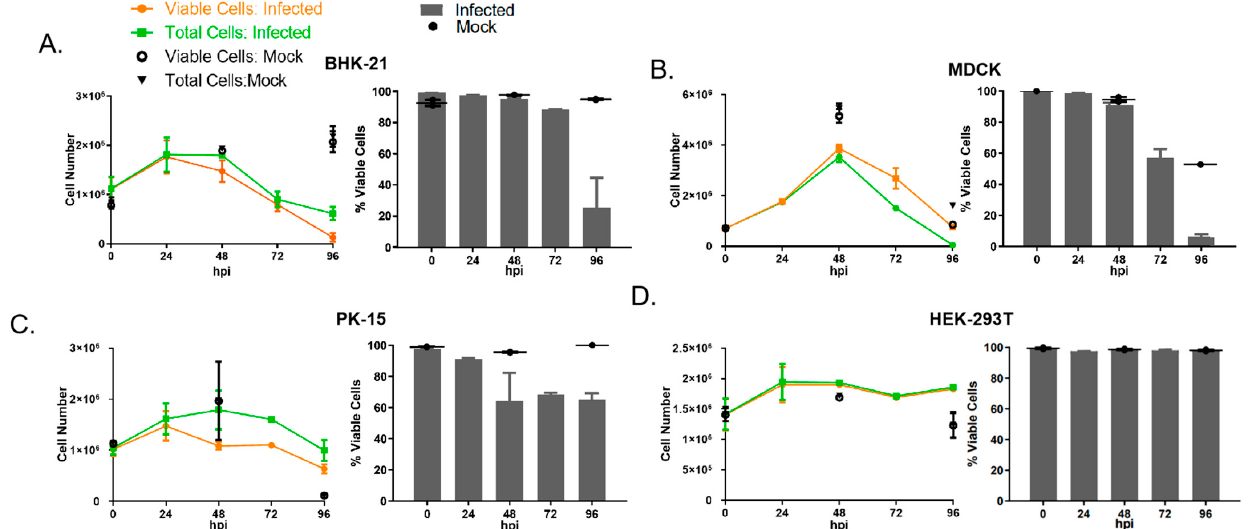
Figure 2. Cell numbers and viability following infection with WUXV SXWX1813 ‐ 2. ( A ) BHK ‐ 21, ( B ) MDCK, ( C ) PK ‐ 15 and ( D ) HEK ‐ 293T cells were infected with WUXV SXWX1813 ‐ 2 at a multiplicity (MOI) of 0.05 and collected at 0, 24, 48, 72, and 96 hpi; mock ‐ infected samples were collected at 0, 48, and 96 hpi. Left panels show the absolute numbers of total cells and viable cells per well at each timepoint based on trypan blue exclusion. Right panels show the percent viability at each timepoint. Bars represent arithmetic mean ± SD of two biological